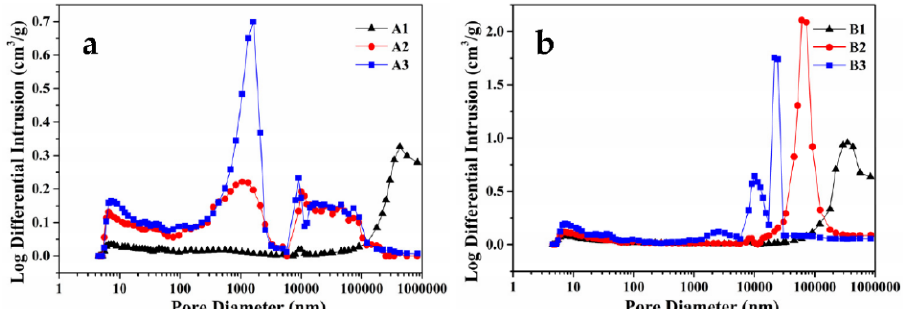
Figure 3. Pore-size-distribution profiles of the mudstone ( a ) and coal ( b ) specimens with distinct granule diameters from the MIP measurement.